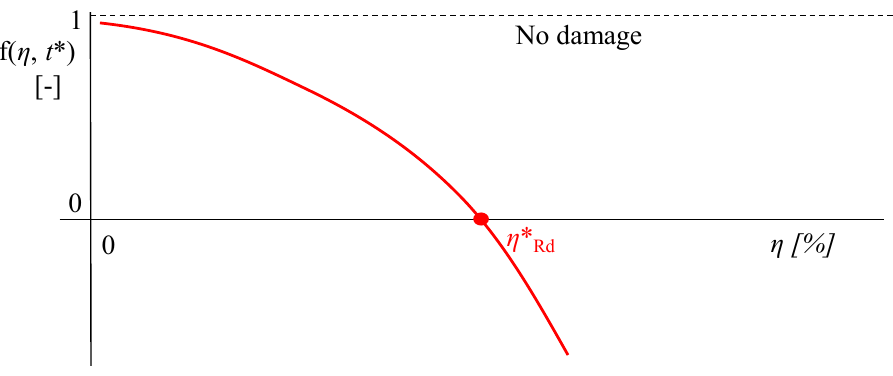
Figure 4. Monotonic trend of f ( η , t *) and corresponding value of η * Rd for f ( η , t *) = 0.